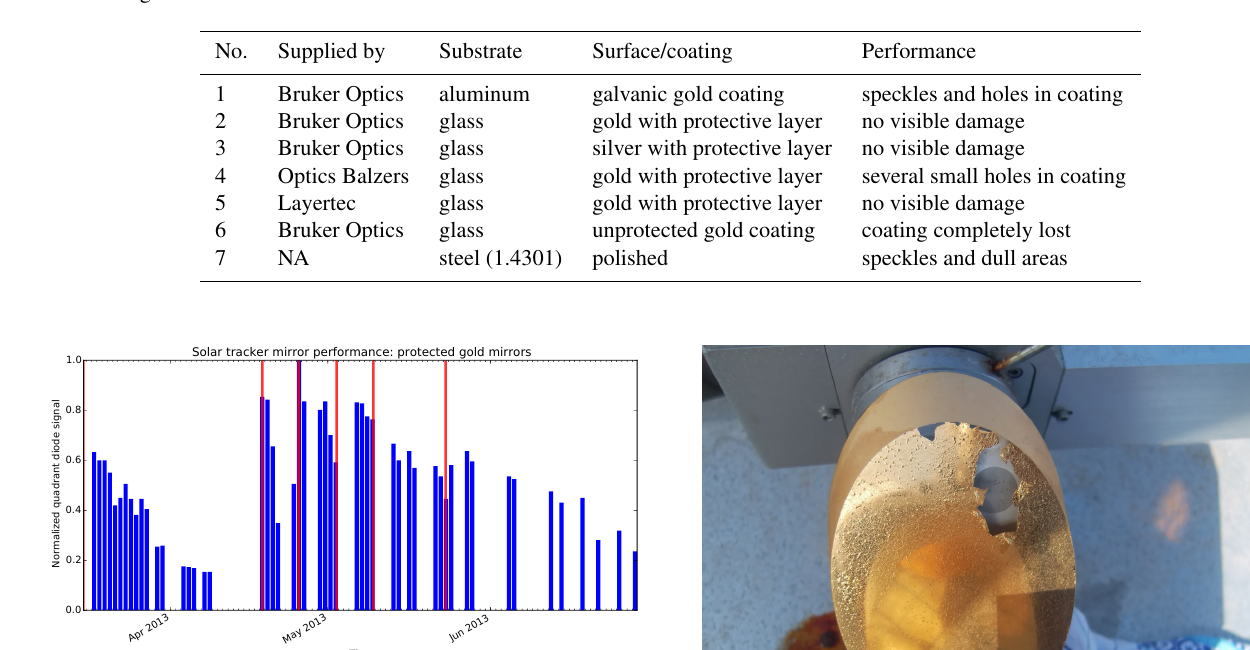
Table 1. Results of mirror test after 1 month of outdoor exposure on Ascension Island. Details about the mirror suppliers are provided in the acknowledgements.